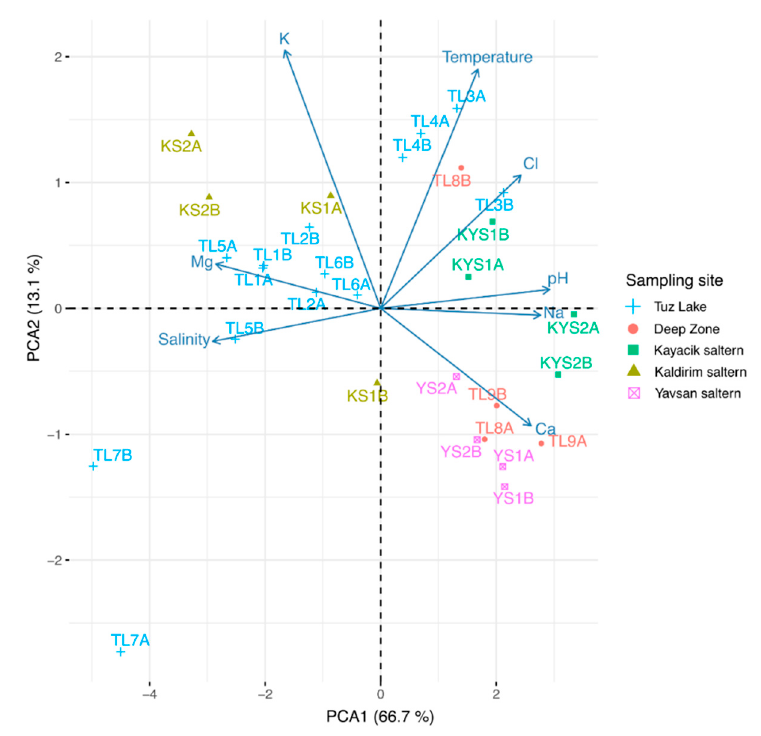
Figure 6. PCA biplot of Tuz Lake, Deep Zone, and Kayacik, Kaldirim, and Yavsan salterns’ brine samples and physico-chemical parameters (blue arrows). The two PCA axes (Dim1 and Dim2) explained 79.8% of data variance. The brine samples are shown in the PCA biplot according to their relationship with the physico-chemical parameters.